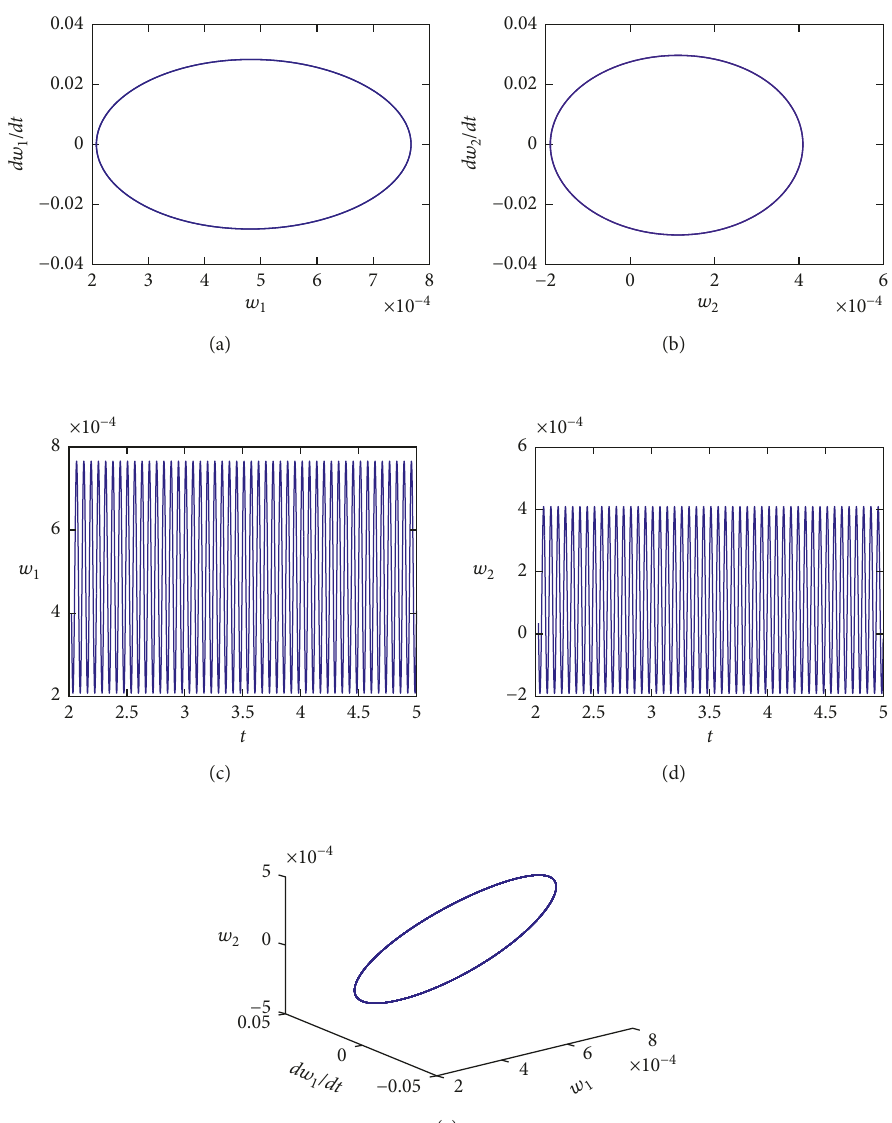
Figure 5: Periodic motions of the cantilever honeycomb sandwich